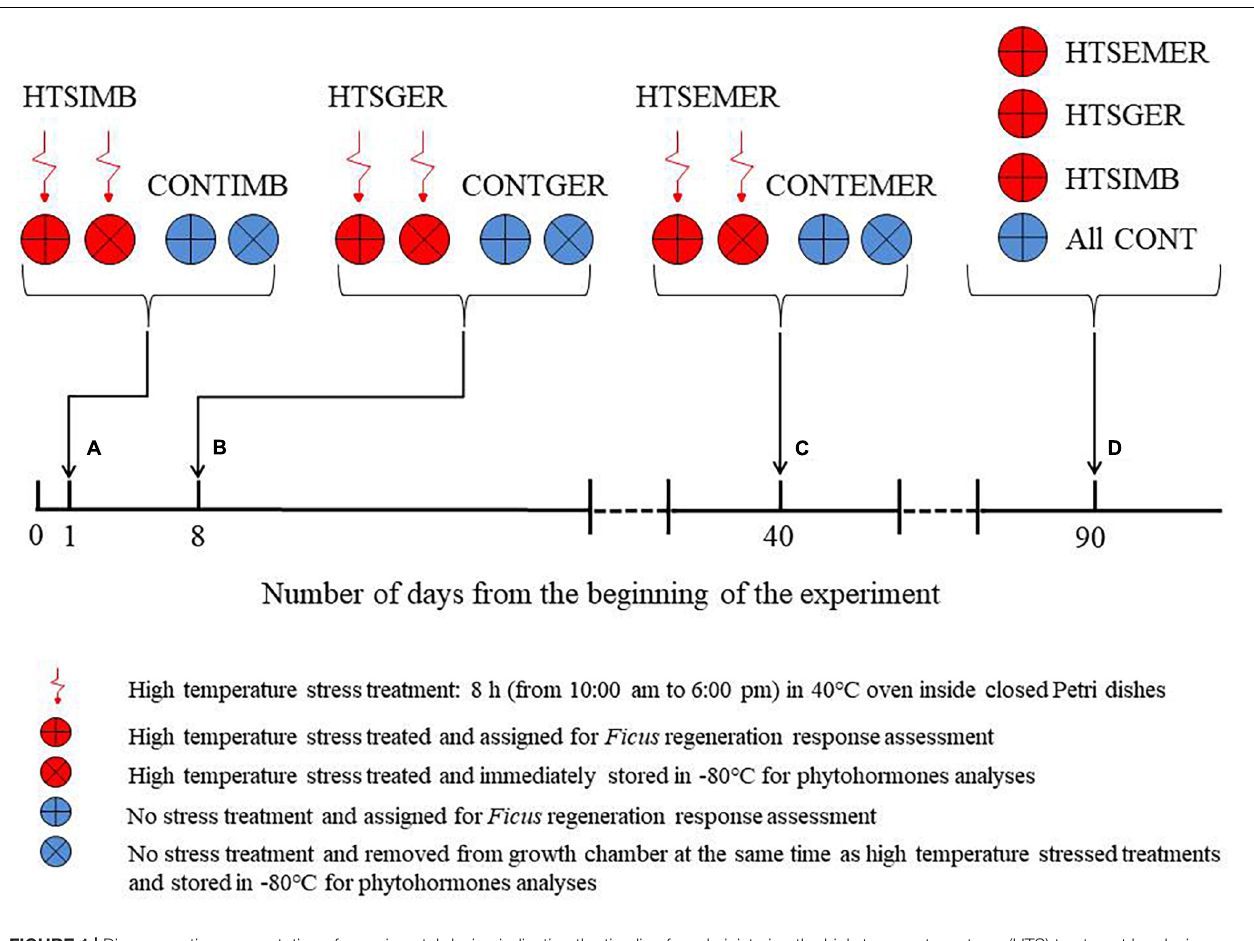
FIGURE 1 | Diagrammatic representation of experimental design indicating the timeline for administering the high-temperature stress (HTS) treatment by placing Petri dishes in 40 ◦ C temperature stress treatment for 8 h from 10:00 to 18:00 in a conventional oven: (A) 24 h after the experiment began during the time seeds undergo imbibition (IMB), (B) 8 days after the experiment began during seed germination (GER), and (C) 40 days after the experiment began during seedling emergence (EMER). We implemented the 40 ◦ C temperature stress treatment at each level just once in the duration of the experiment. All temperature stress-treated Petri dishes with seeds or seedlings were returned to the growth chamber at the end of each treatment. Each HTS treatment had a control (CONT) at 25/15 ◦ C day/night temperature and thus, we had a total of 512 Petri dishes and six treatment conditions (HTSIMB and CONTIMB, HTSGER and CONTGER, and HTSEMER and CONTEMER). The experiment was concluded in 90 days (D) . There were additional 192 Petri dishes that were assigned to destructive sampling for the phytohormone